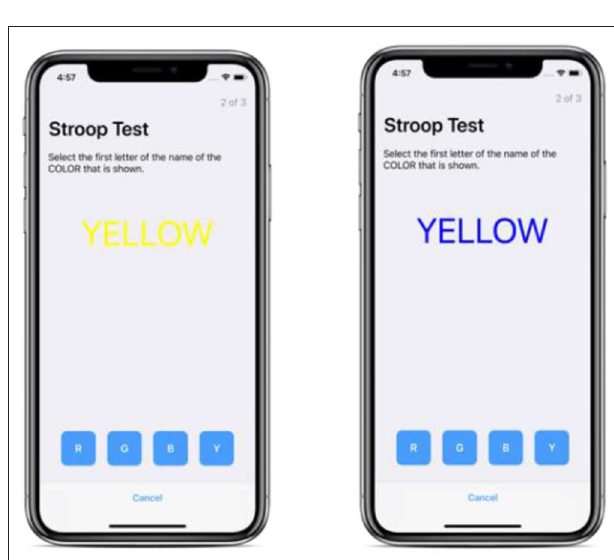
FIGURE 2 | Samples of Stroop